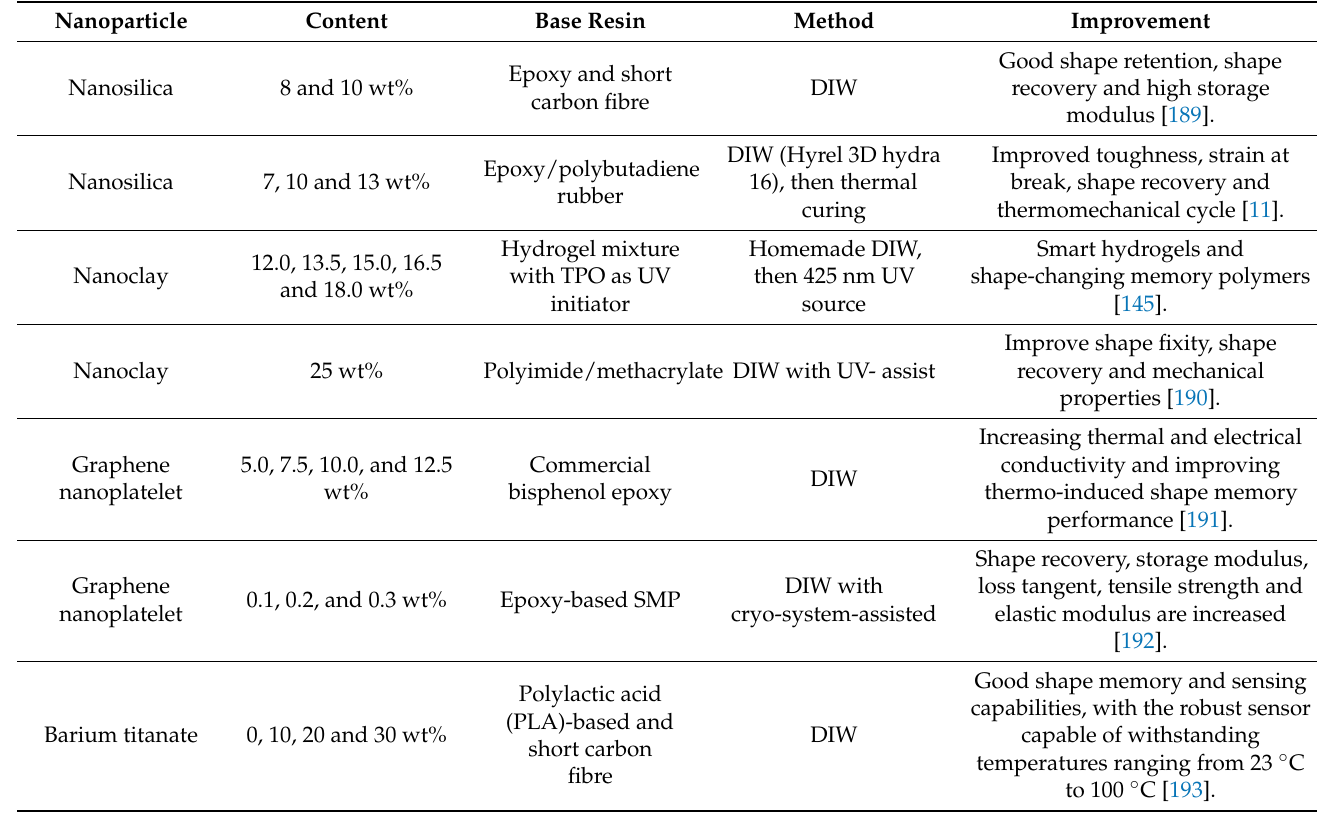
Table 2. List of DIW 4D-printed shape memory nanocomposites and their improved